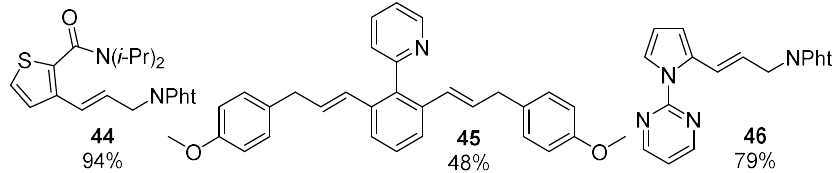
Figure 4. Selected compounds prepared by Xu, Zhang, and co-workers [89].